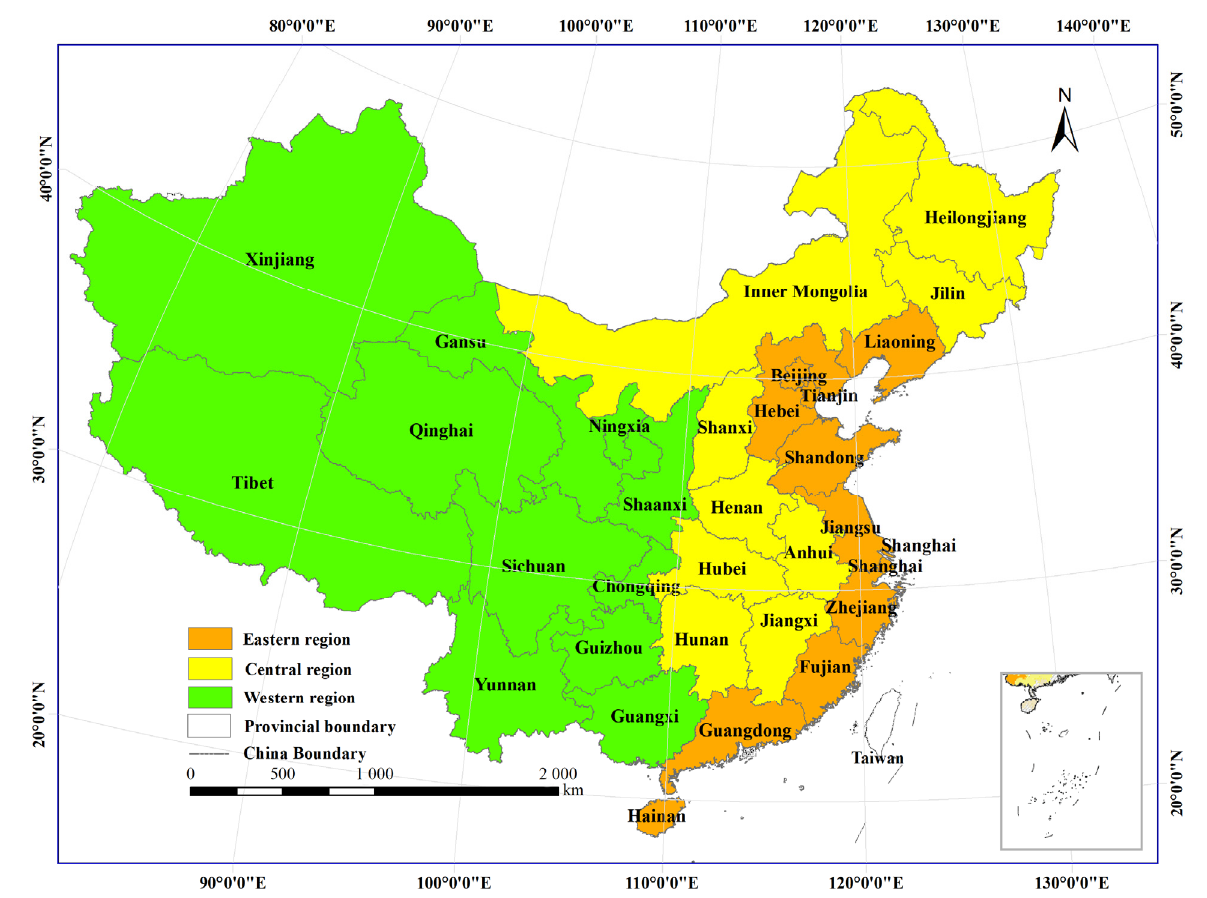
Figure 1. The statistics of impact factors for China and the three regions are summarized in Figure 2 and Tables 1 and 2.